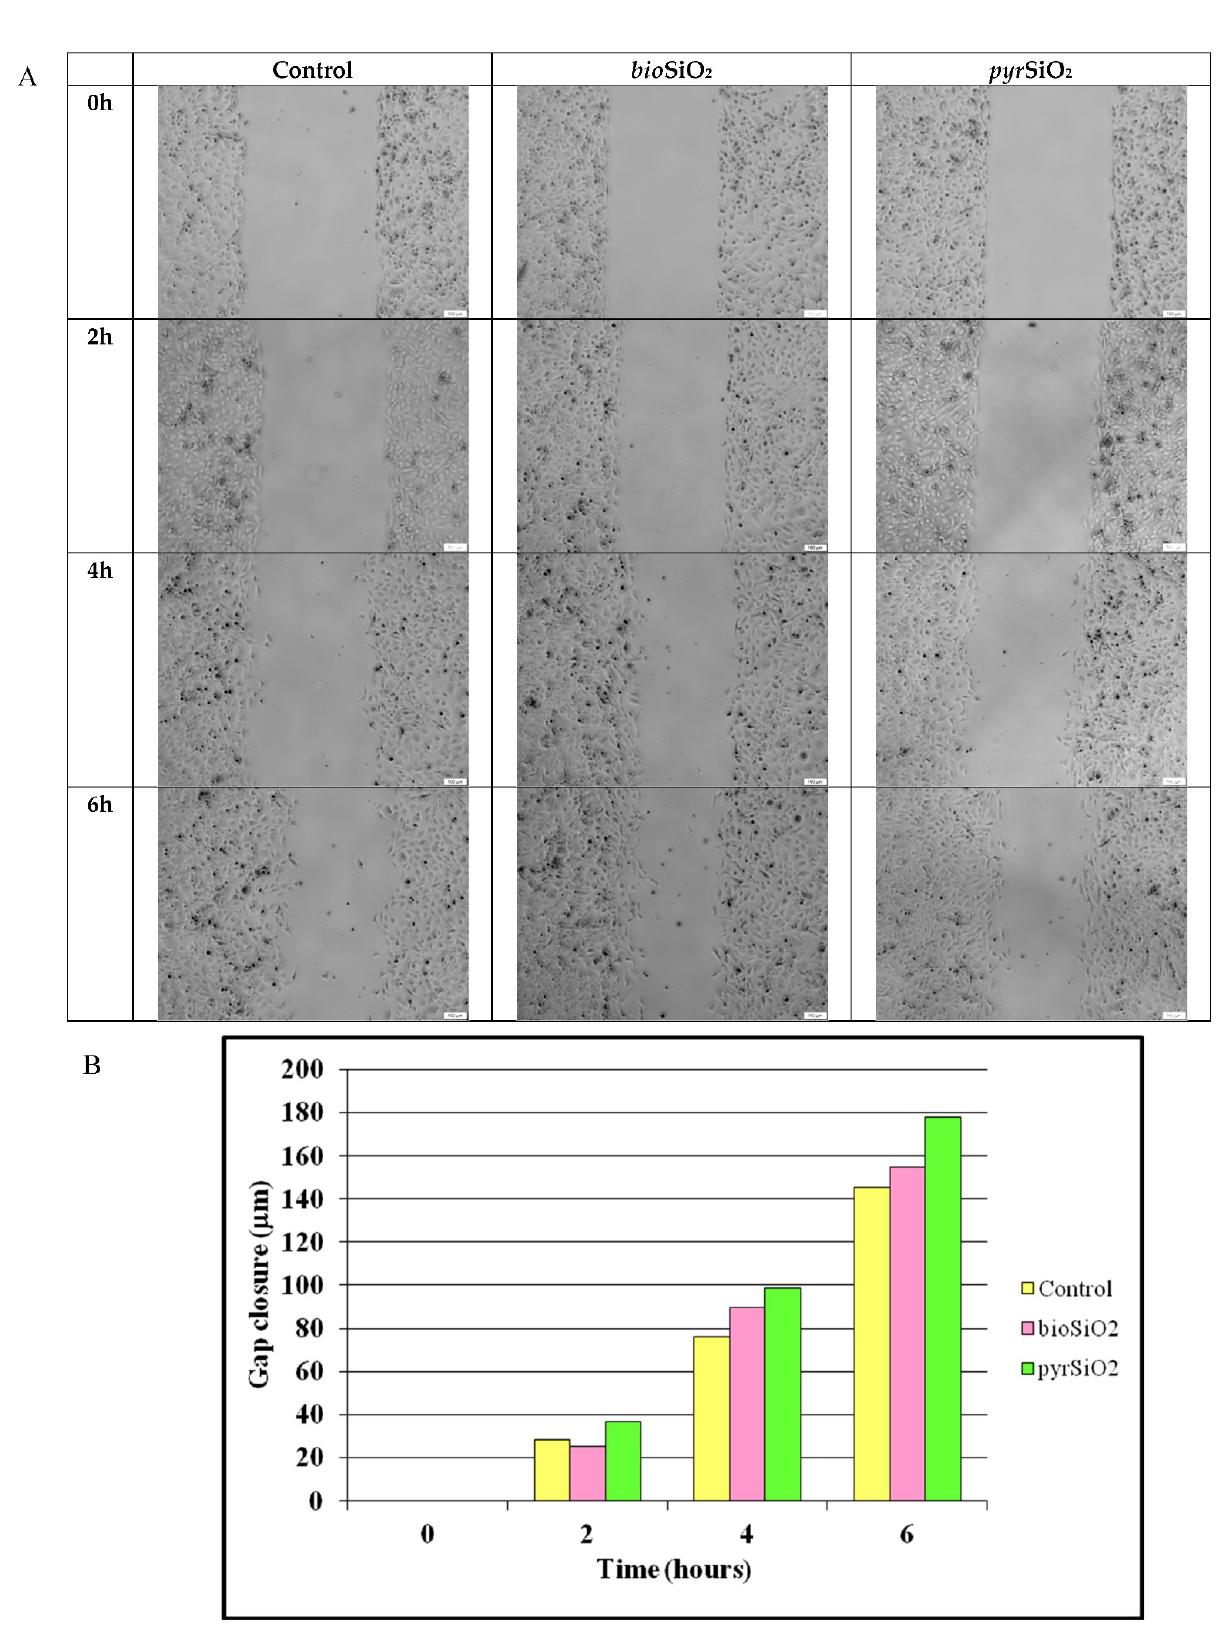
Figure 6. Impact of biogenic and pyrogenic silica nanoparticles on cell motility in vitro. ( A )—the migration distance (the distance of the gap was measured in μm); ( B )—the speed of the cell migration (relative migration = gap area at 0 h, 2 h, 4 h, or 6 h). V (speed) = S (road in μm)/t (time in h). Samples were imaged using a light microscope, 40×. Scale bar: 100 μm.